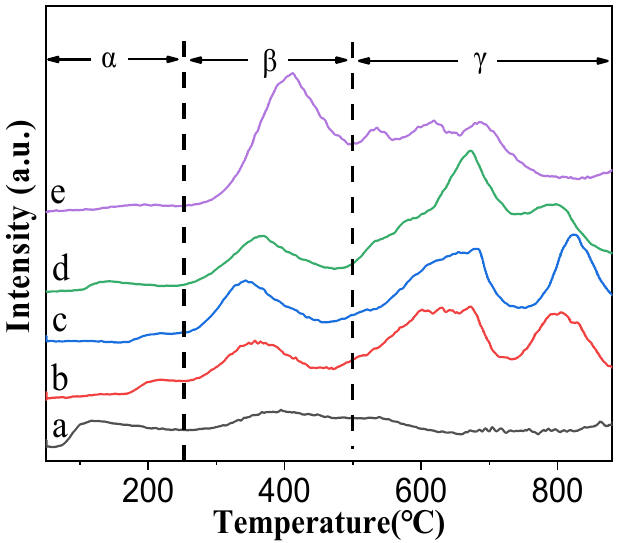
Figure 5. O 2 -TPD of prepared catalysts ( a : M-TSO; b : MnCeO x /M-TSO; c : K 0.1 MnCeO x /M-TSO; d : K 0.5 MnCeO x /M-TSO; e : K 1 MnCeO x /M-TSO).